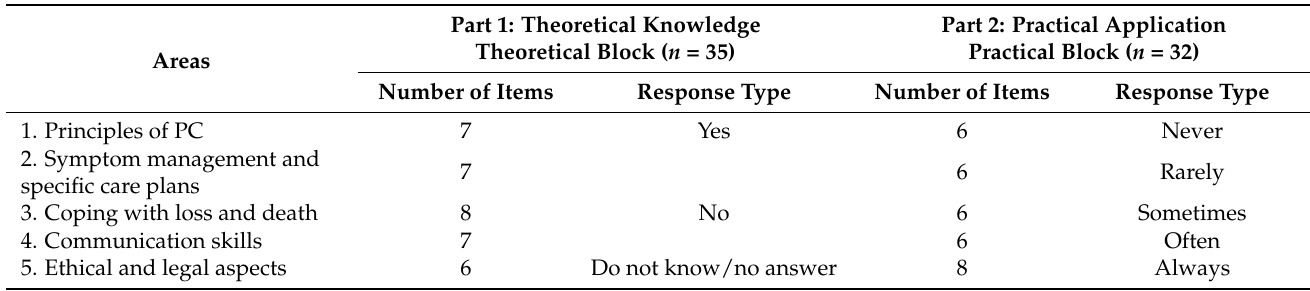
Table 1. The INCUE questionnaire one item